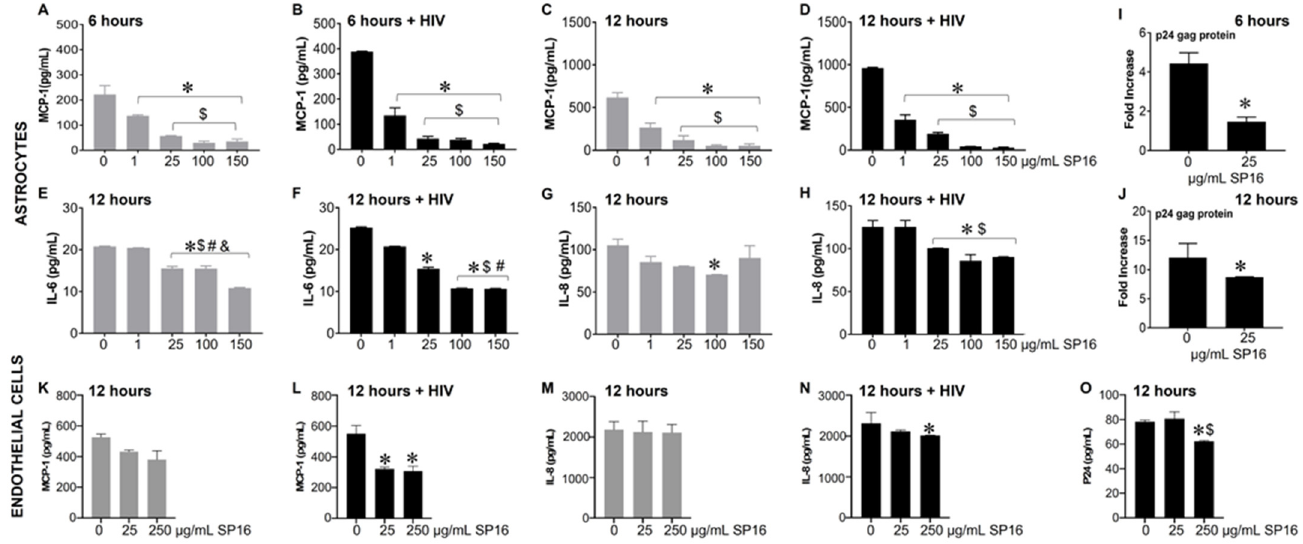
Figure 3. Anti-inflammatory and anti-viral responses of SP16 in astrocytes and endothelial cells. Supernatant was collected after 6 (astrocytes) and 12 (astrocytes and endothelial cells) hours and used to measure inflammatory molecules ( A – H ) in astrocytes, ( K – N ) in endothelial cells, and viral protein p24 ( I , J ) in astrocytes, ( O ) in endothelial cells, by ELISA. Gray bars = non-infected cells, black bars = infected cells. Results are reported as the mean ± SEM of 3 independent experiments. Data were analyzed using one or two-way ANOVA analysis followed by Dunnett multiple comparisons. A value of p < 0.05 was considered significant. * vs. media; $ vs. 1 μ g/mL SP16; # vs. 25 μ g/mL SP16 (in astrocytes); $ vs. 25 μ g/mL SP16 (in endothelial cells); & vs. 100 μ g/mL SP16.